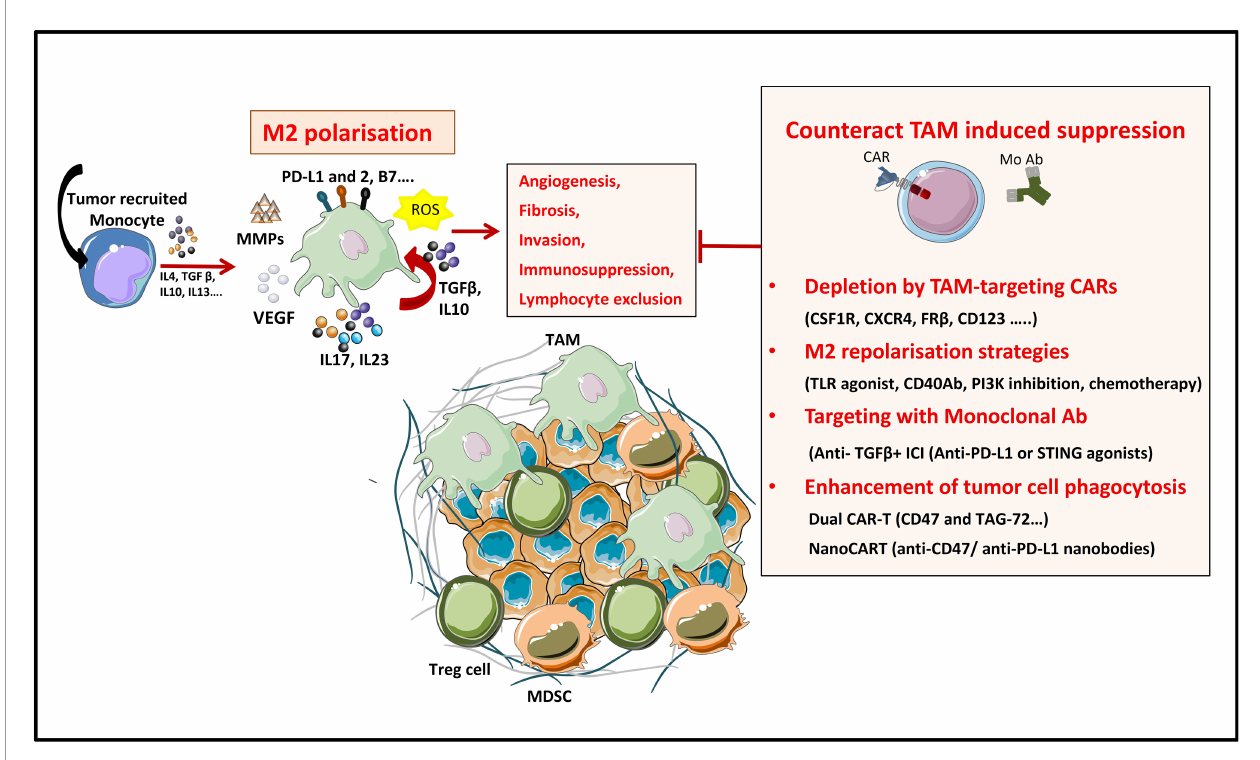
FIGURE 4 | Strategies to overcome TAM ’ s induced suppression in the TME. TAMs are a tumor promoting immune populations derived under a speci fi c cytokine milieu either from blood circulating monocytes or from tumor resident macrophages. TAMs exert their tumor promoting and immunosuppressive role by means of cell-to cell contact (inhibitory check point ligands), by secreting soluble factors (like cytokines IL10, IL17, L23), by producing ECM-modifying enzymes (MMPs) or by producing reactive species of oxygen (ROS). All these factors promote tumor progression. TAMs directed therapies in the TME aim either at (1) speci fi cally depleting the TAM population, at (2) reprogramming M2 towards proin fl ammatory M1 phenotypes, at (3) targeting TAM-secreted factors or 4) at enhancing TAM ’ s phagocytic functions in the